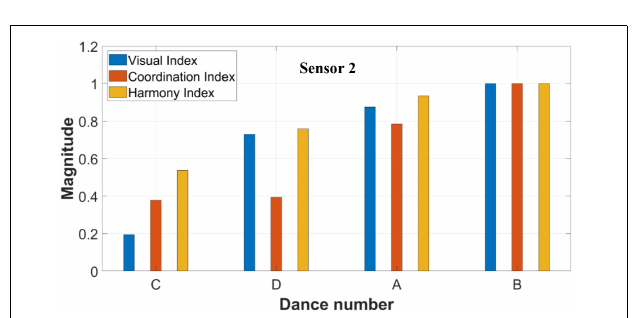
FIGURE 9 | Visual Index, Coordination Index, and Harmony Index generated from sensor